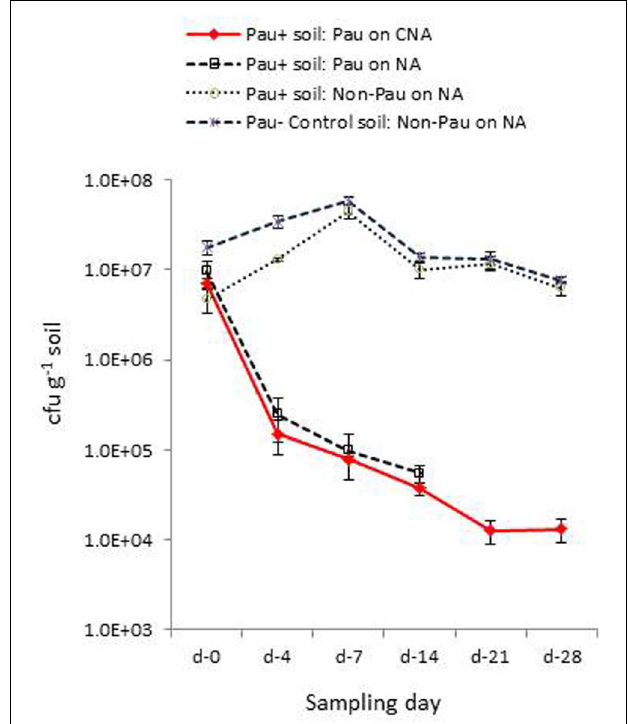
FIGURE 5 | Extent of P. aeruginosa ( Pau ) and non- Pau bacterial cfu in potted Pau -inoculated ( Pau + ) and control ( Pau − ) rhizospheric soil mix on different sampling dates commencing from the date of Pau application (day-0) as per the cfu estimations on selective CNA and NA (cumulative of cfu recorded on day-1 to day-4; vertical bars indicate standard